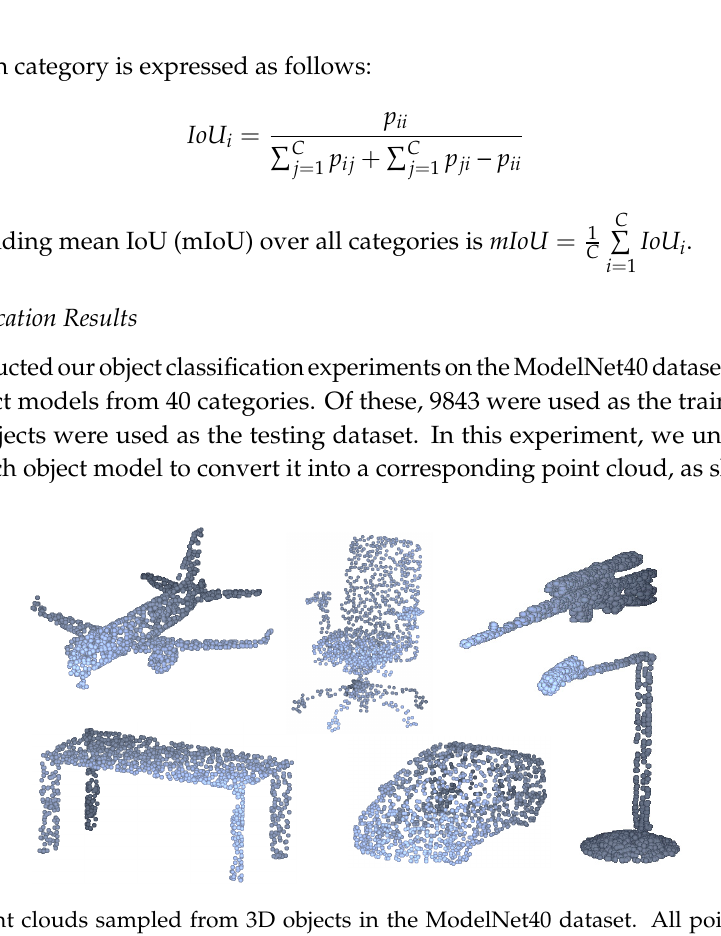
Table 1. Object classification results on the ModelNet40 dataset with different methods. For comparison, results of another method KPConv [51] using a similar conception of 3D kernels are also listed. The batch size for network inference is set as 16 for all experiments.